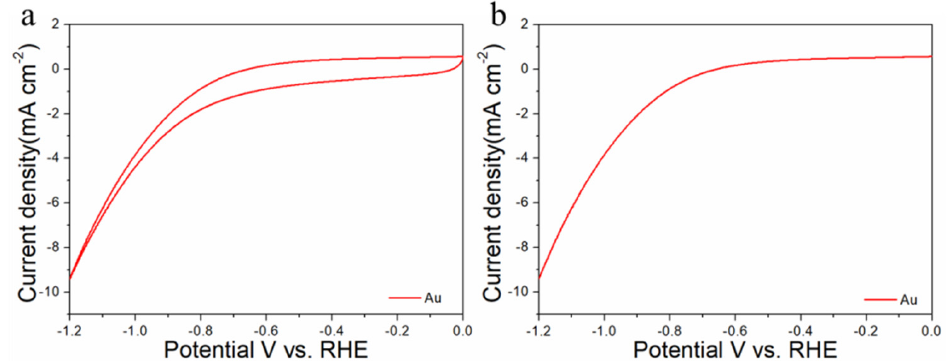
Figure 9. Cyclic voltammograms ( a ) and linear scan voltammograms ( b ) of Au/C in CO 2 -satruated 0.1 M KHCO 3 solution collected at a scan rate of 20 mV s − 1 .